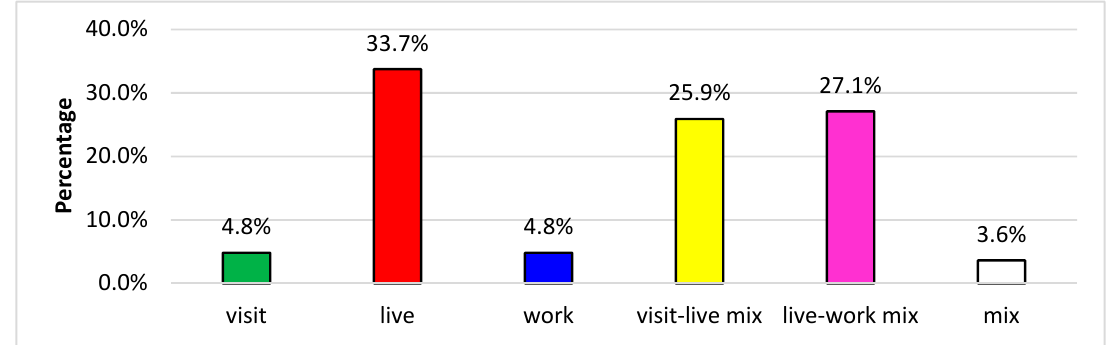
Figure 11. Percentage of buildings in different types of functional mix.